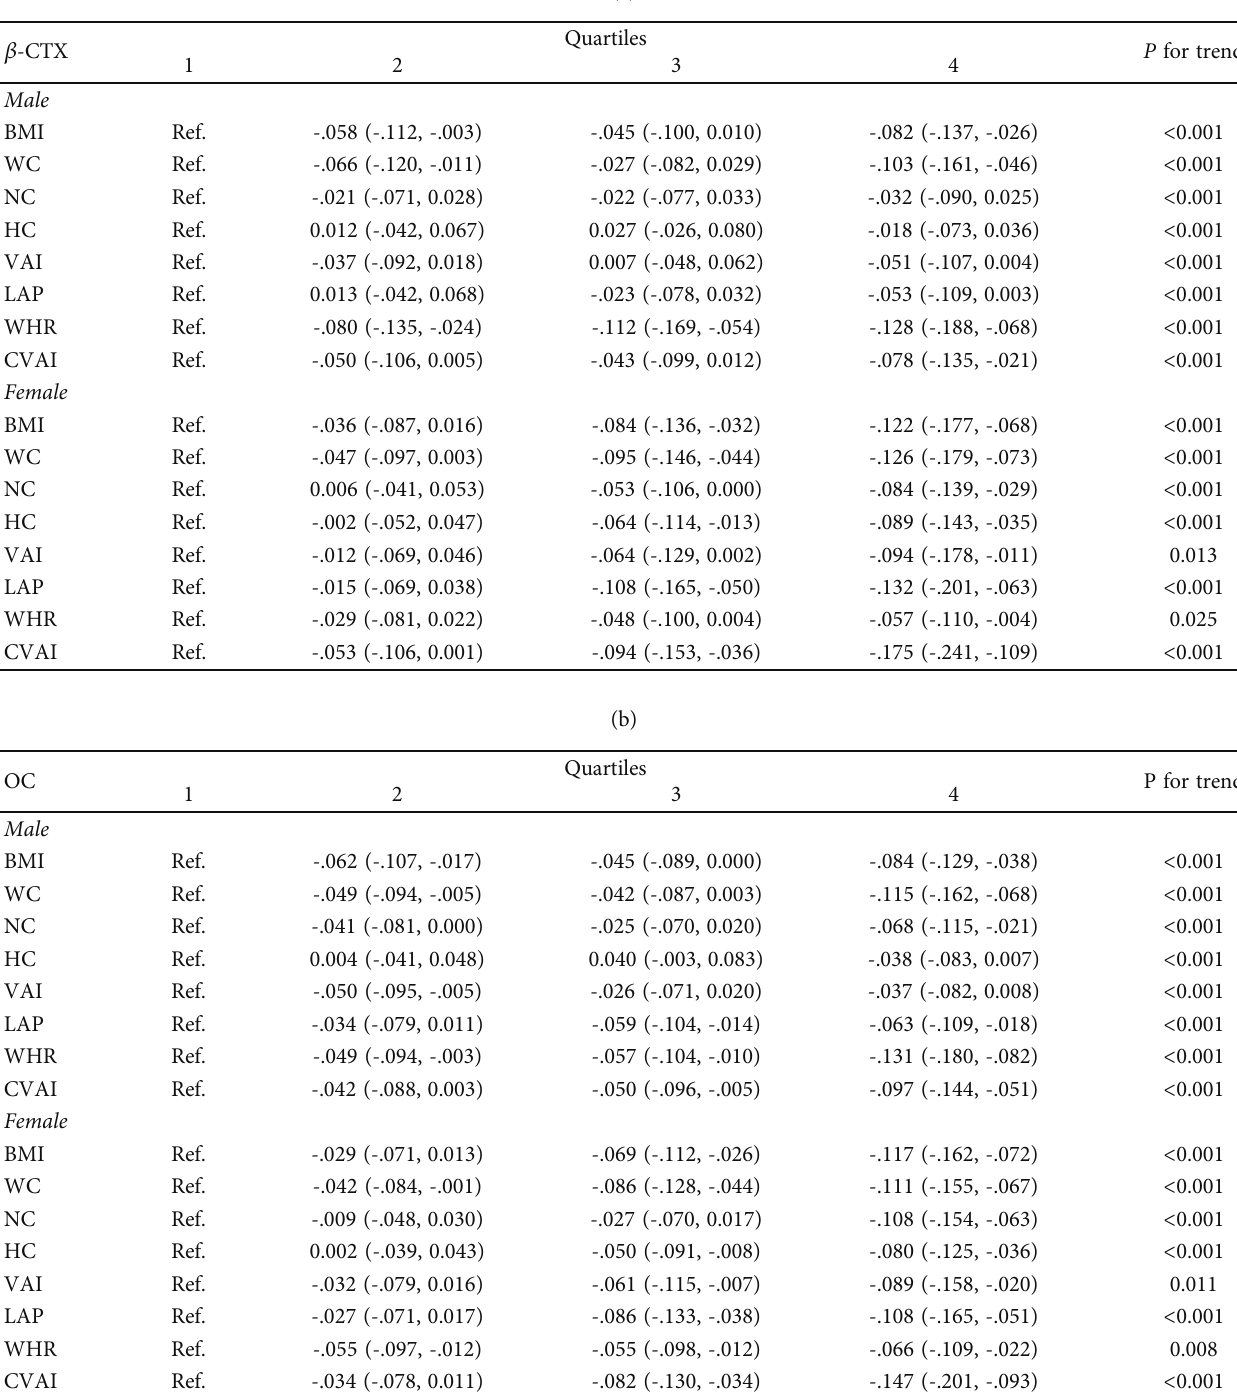
Table 3: P for trend of abdominal obesity index concentration with BTM quartile